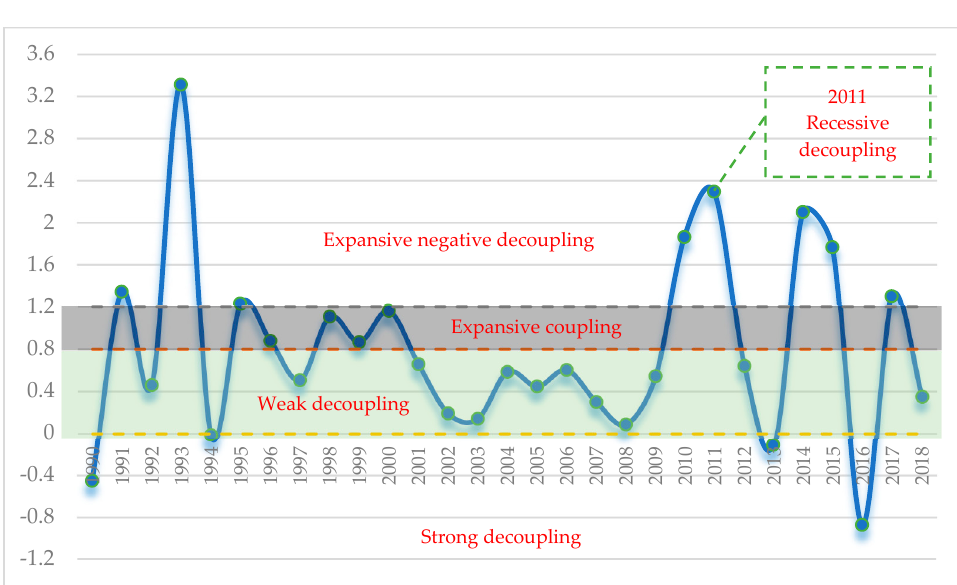
Figure 2. Trend of decoupling effect of GHG footprint in Tunisia.